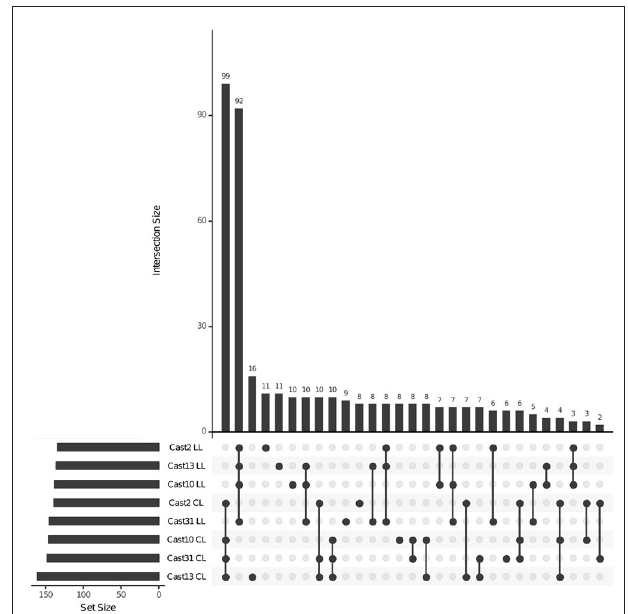
FIGURE 6 | Loci lost across T. castellanus individuals . Set IDs represent samples where either T. crocifolius (C) or T. lamottei (L) homoeologs are lost (L). Overlapping sets are indicated by filled circles, and the number of loci within that intersection may be seen directly above in the bar chart with corresponding size over each bar. The total sample sizes are found in the left bar chart and correspond to the adjacent sample. As expected, there should be no overlap across T. crocifolius and T. lamottei